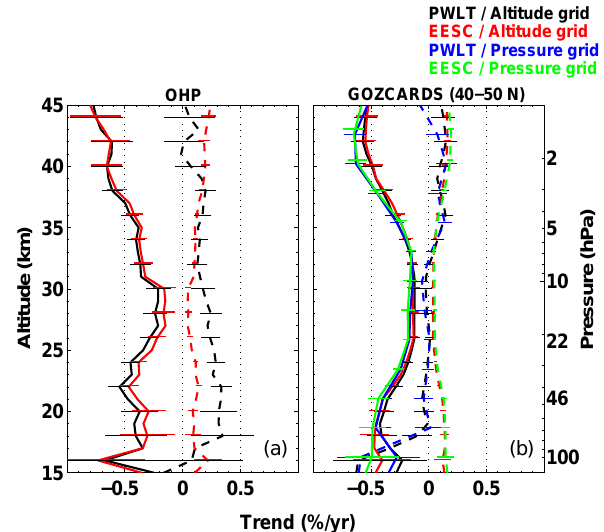
Fig. 8. (a) Vertical structure of the year-round PWLT (black) and EESC-based (red) ozone trends over the range 15–45km estimated from average ozone anomalies from the OHP-related data sets. (b) The PWLT (black) and EESC-based (red) ozone trends esti- mated on an altitude grid in 1km spacing and PWLT (blue) and EESC-based (green) trends calculated on GOZCARDS pressure grid from the GOZCARDS monthly ozone anomalies for 40–50 ◦ N. The solid and dashed lines represent ozone trends over the periods 1984–1996 and 1997–2010, respectively. The dotted lines represent − 0.5, 0 and 0.5%yr − 1 . The error bars denote twice the standard